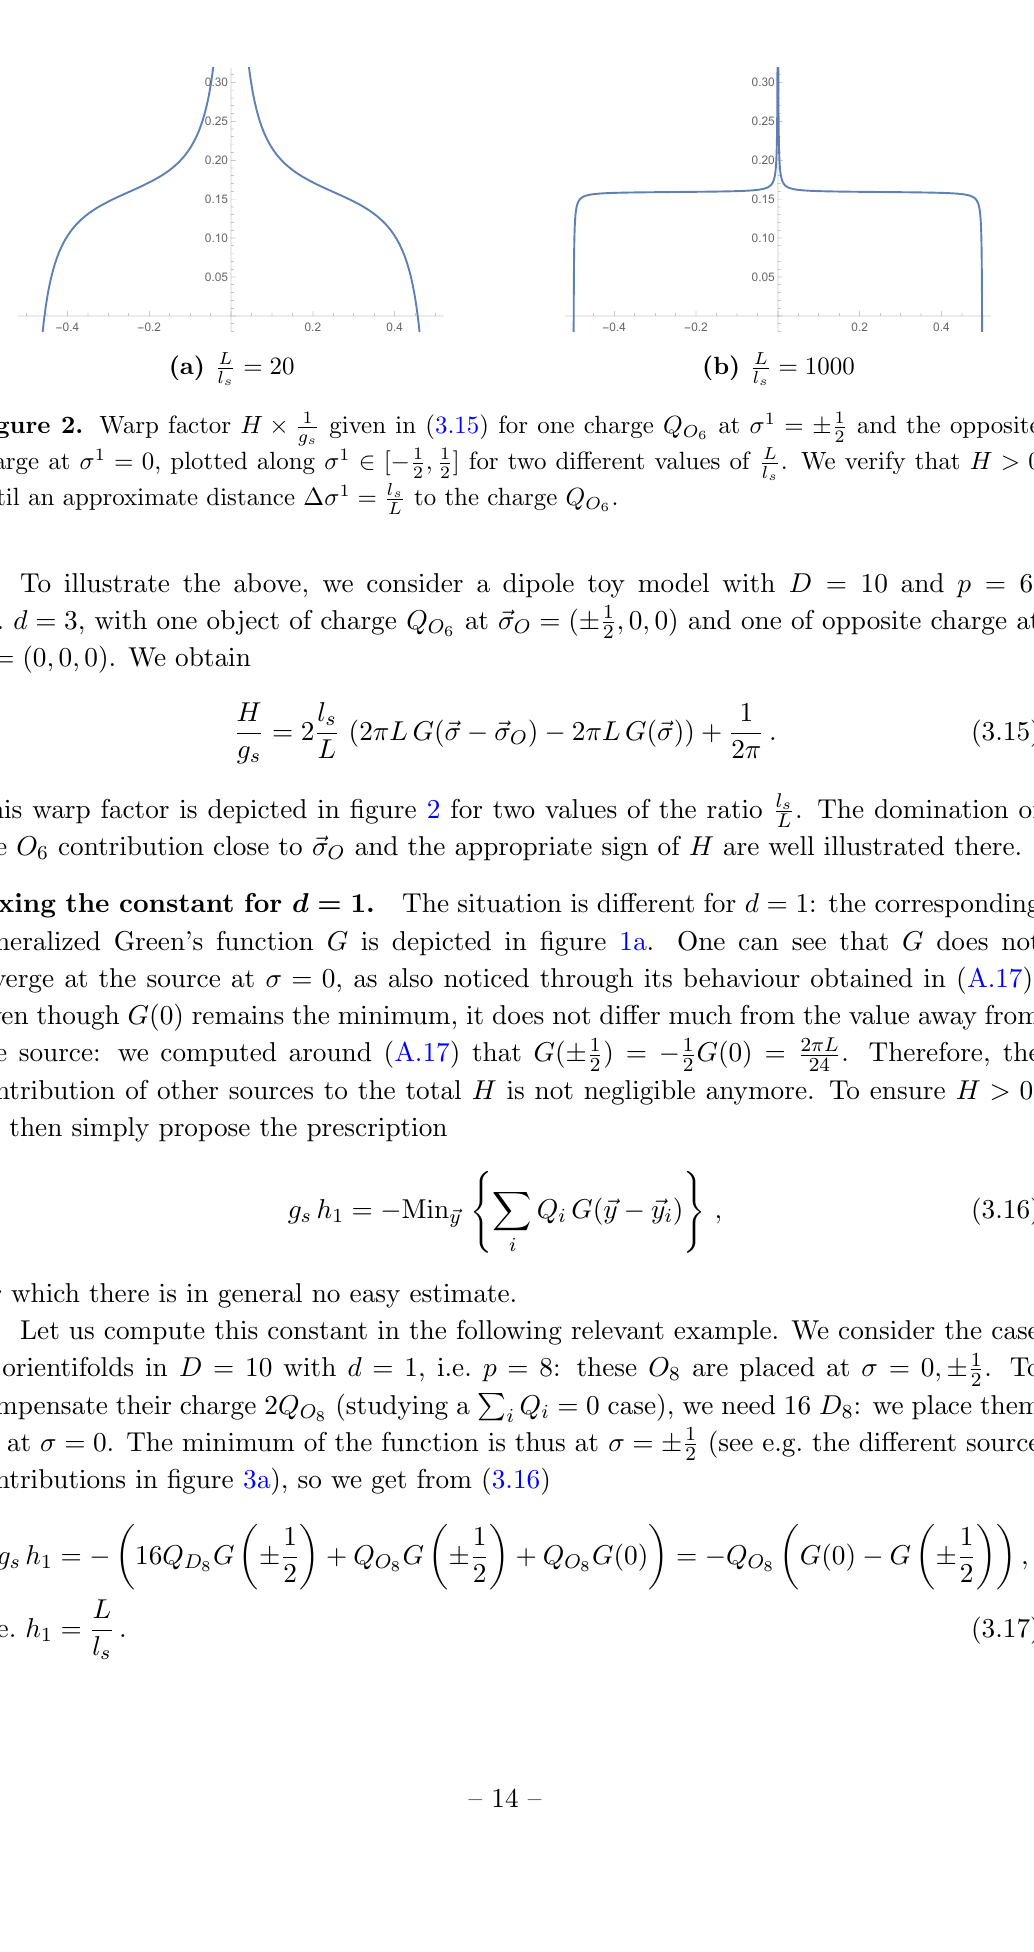
Figure 2. Warp factor H (cid:2) 1 charge at (cid:27) 1 = 0, plotted along (cid:27) 1 2 [ (cid:0) 1 until an approximate distance (cid:1) (cid:27) 1 = l s